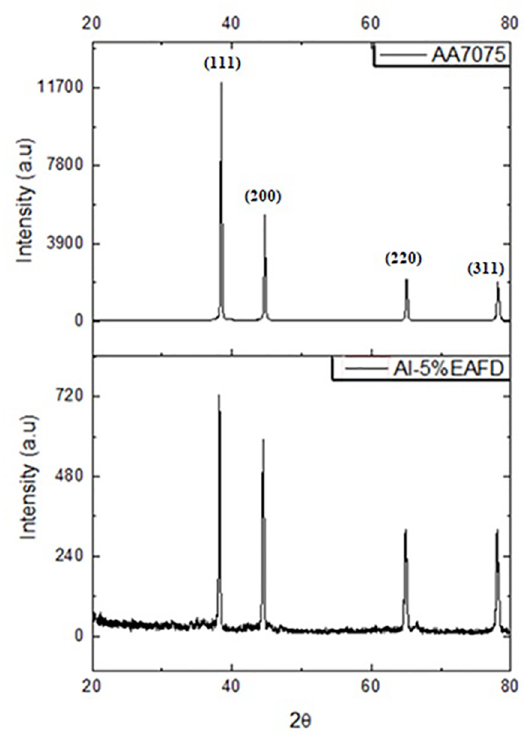
Figure 6. X-ray diffraction difractogram of Al-5%EAFD sintered composite and AA7075 alloy as